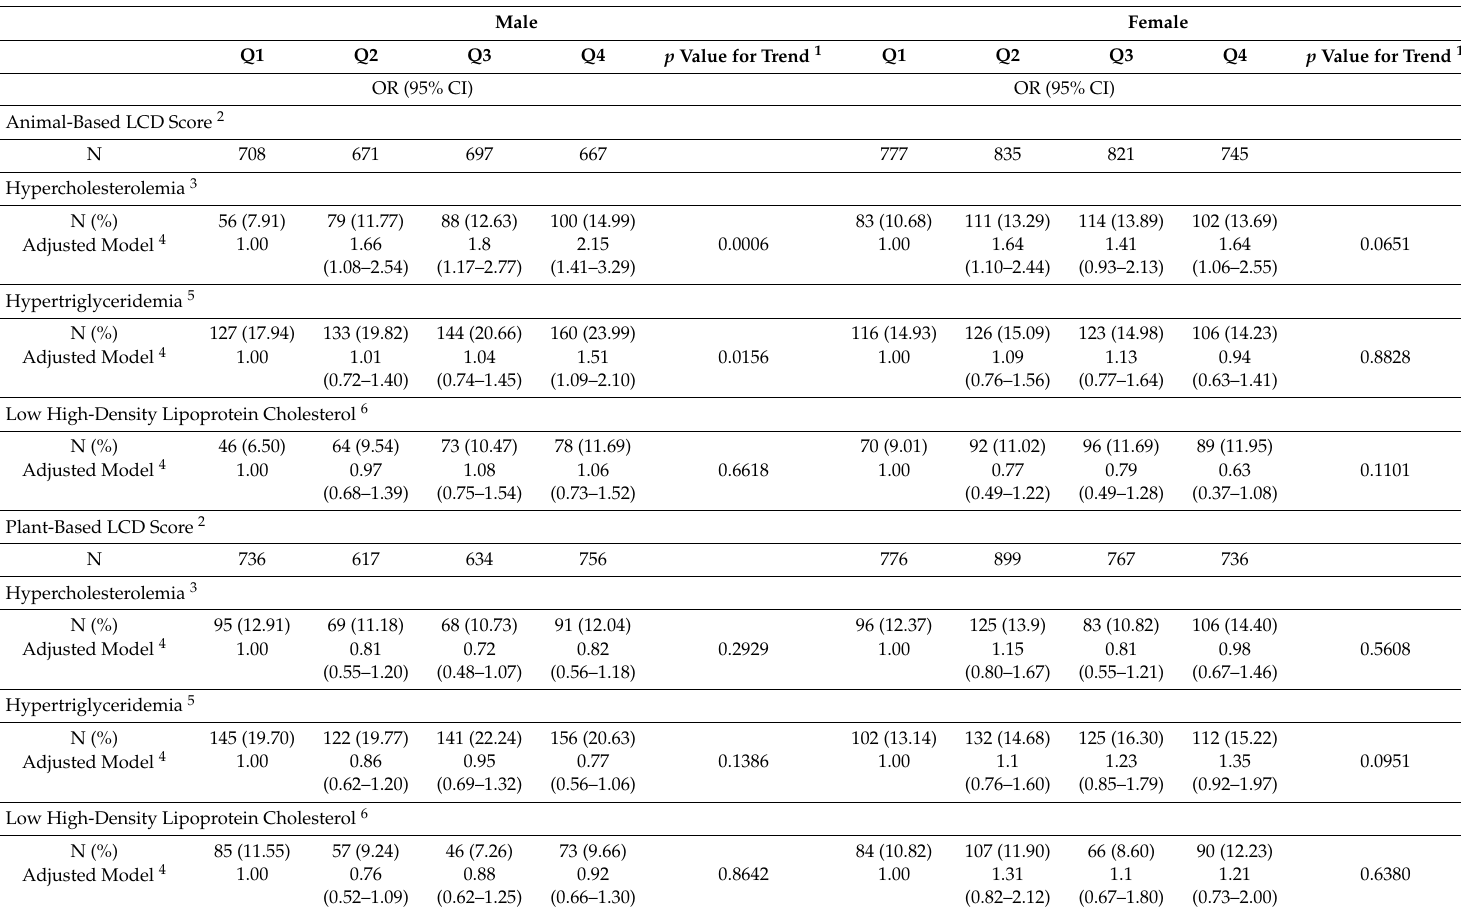
Table 6. Multivariate adjusted odds ratios (ORs) for dyslipidemia according to the quartiles (Q) of animal-based and plant-based low-carbohydrate diet (LCD) scores of Chinese adults, China Health and Nutrition